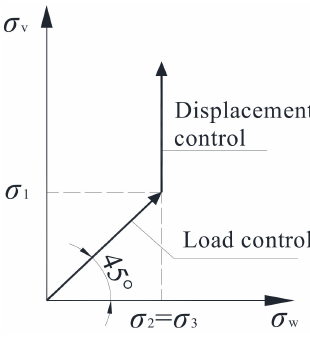
Figure 4. Loading process.